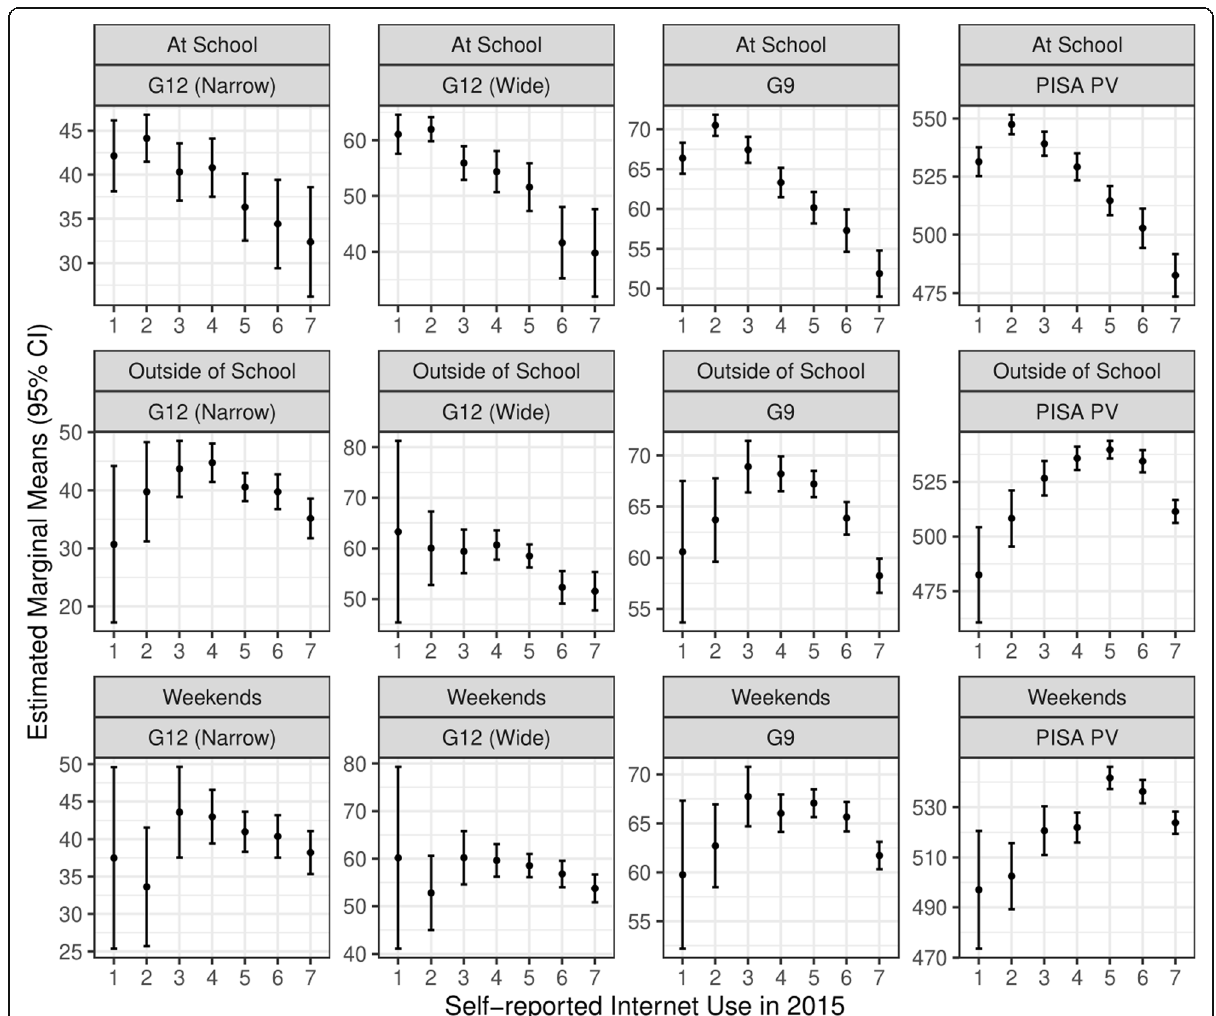
Fig. 1 Estimated marginal means of mathematics scores based on Internet use at and outside of school and on weekends, controlled for SES and gender. Notes : On x -axis (Self-reported Internet Use in 2015): 1 = “ No time ” ; 2 = “ 1 – 30 min per day ” ; 3 = “ 31 – 60 min per day ” ; 4 = “ Between 1 and 2 h per day ” ; 5 = “ Between 2 and 4 h per day ” ; 6 = “ Between 4 and 6 h per day ” ; 7 = “ More than 6 h per day ” . G12 (Narrow) = Grade 12 national mathematics exam (narrow) score; G12 (Wide) = Grade 12 national mathematics exam (wide) score; G9 = Grade 9 national mathematics exam score; PISA PV = PISA 2015 mathematics test scores (estimated across ten plausible values as suggested in OECD (2018). The 95% CIs are